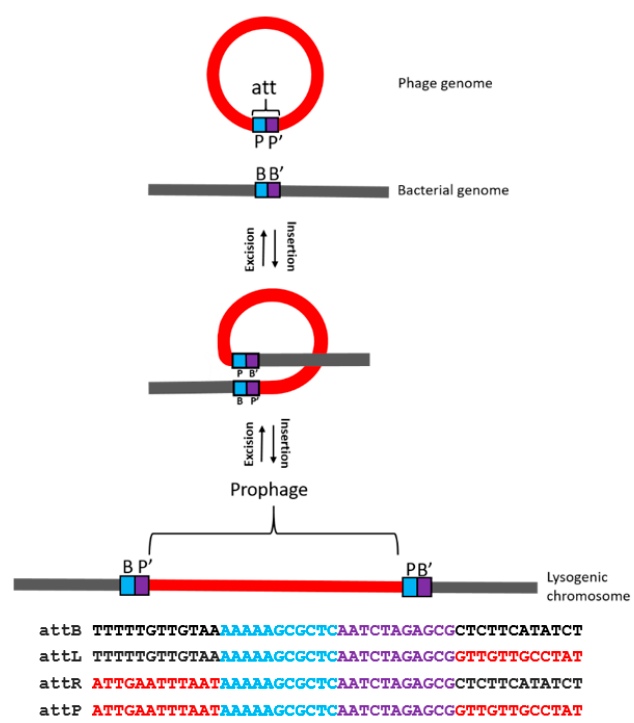
Figure 6. The prophage (red), flanked by attL and attR upon insertion into A. baumannii . The attachment site [ AAAAAGCGCTCAATCTAGAGCG] is the cross-over site for phage integration and